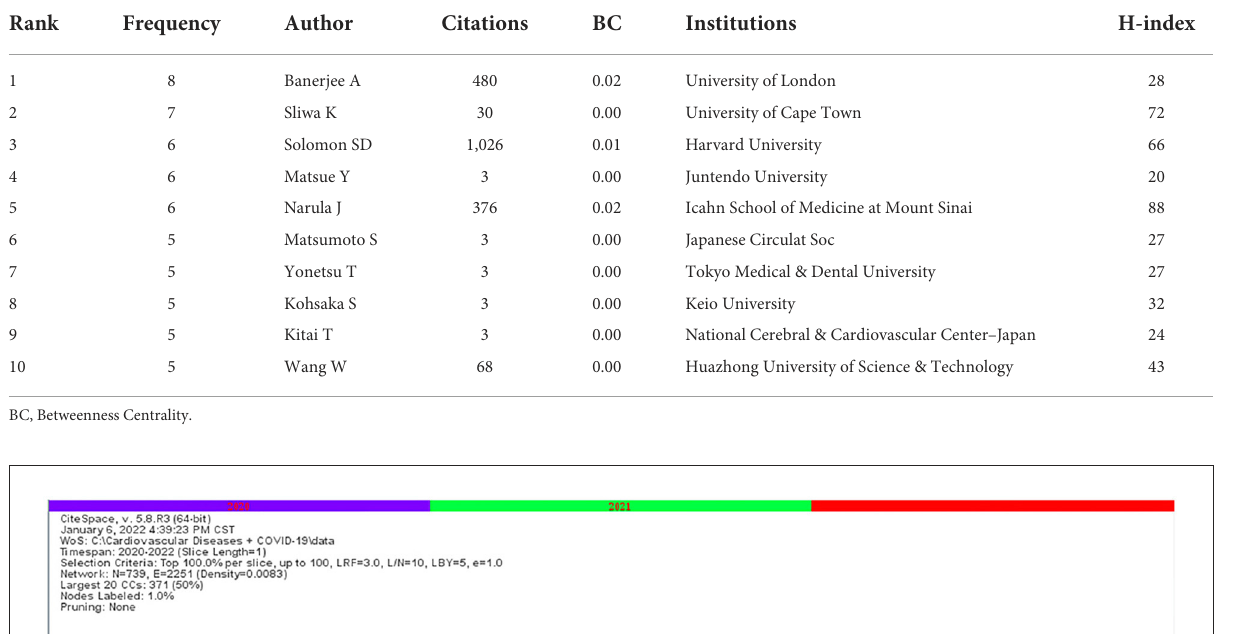
TABLE 3 Top 10 authors in CVDs and COVID-19 research.